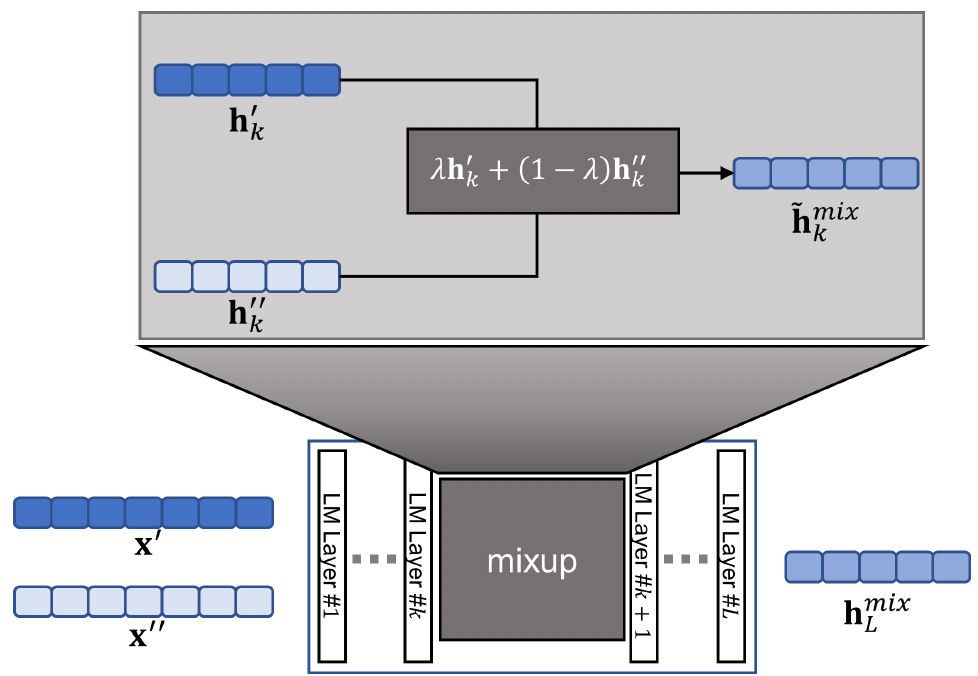
Figure 5. Illustration of the mixup process. We use the TMix [18] strategy to mix text